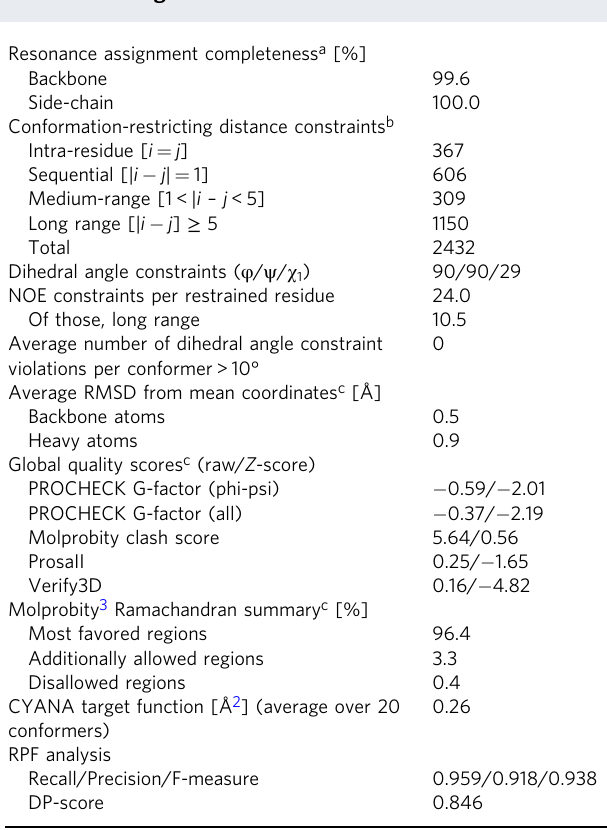
Table 1 NRG1-Ig structure